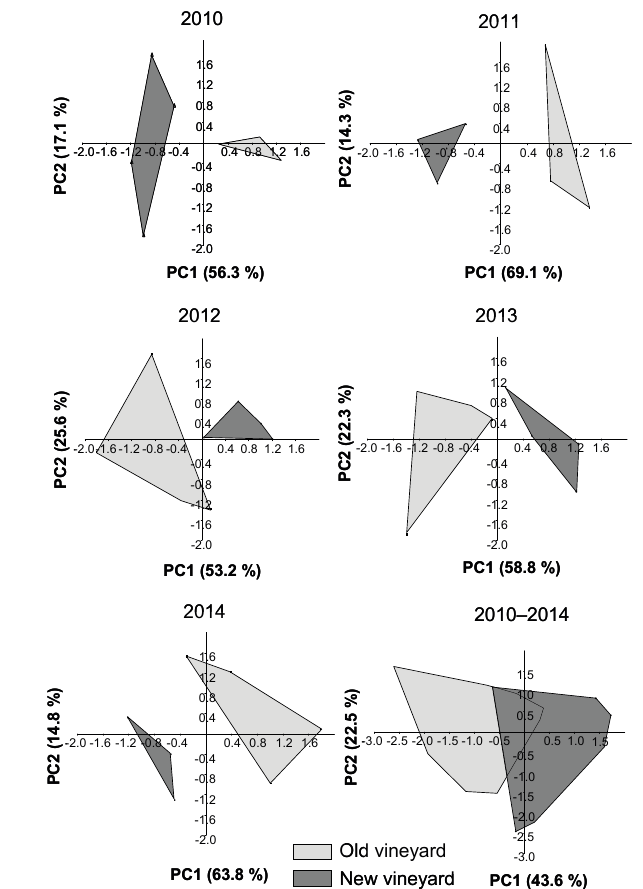
Figure 8. PCA score plots for each year and for the whole study period (not including